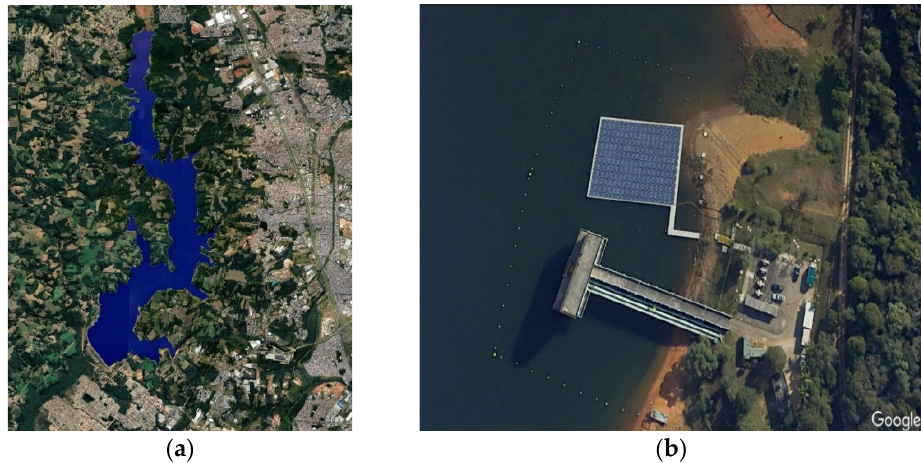
Figure 6. Aerial view of the water surface area of the Passaúna Reservoir and the FPS during the water shortage in 2021: ( a ) Passaúna Reservoir; ( b ) FPS site highlighting the low water level. Google Earth images.